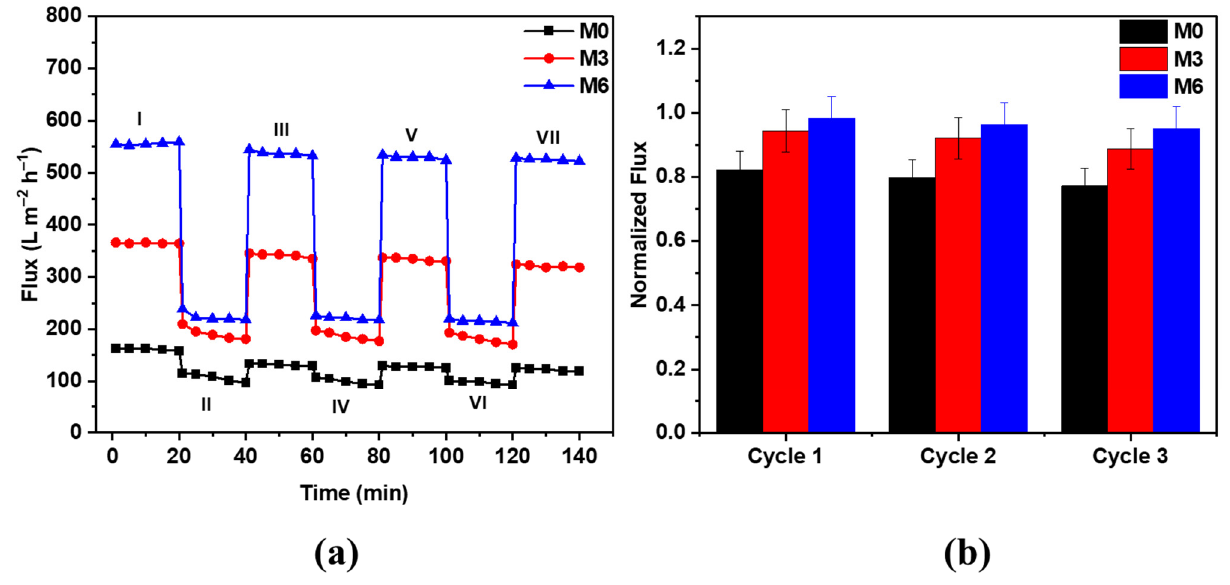
Figure 9 . ( a ) Flux modulation of bare PES (M0), PES/MWCNTs (M3), and PES/GO (M6) hybrid membranes during water (phases I, III, V, and VII) and HA filtration (phases II, IV, and VI) where each phase was run for 20 min, and ( b ) corresponding normalized fluxes for different PES hybrid